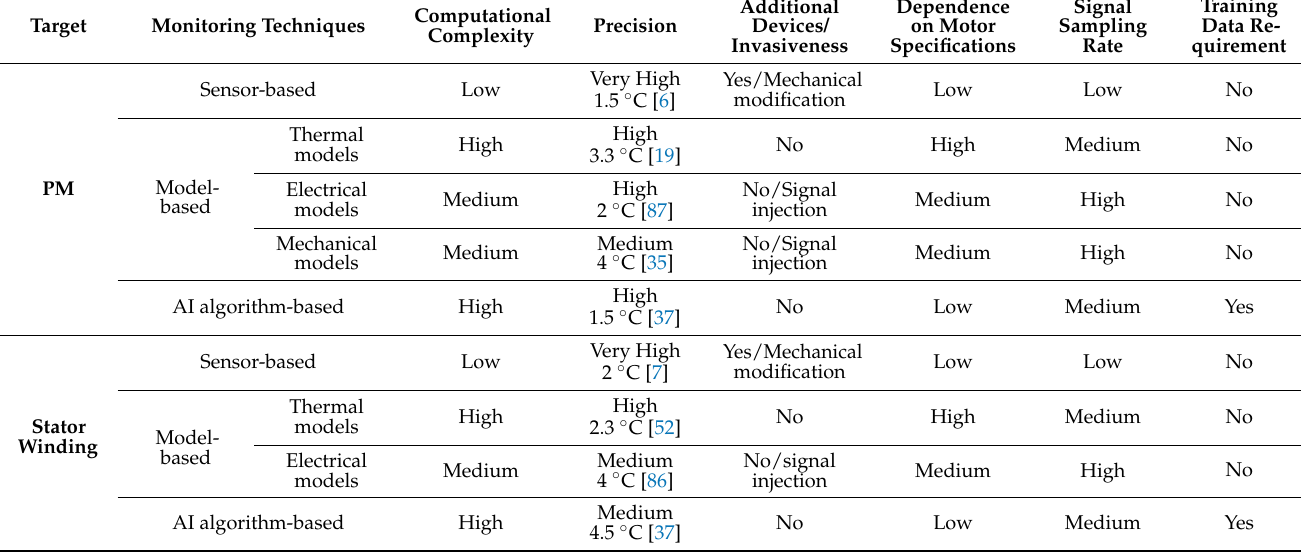
Table 2. Technical comparison of temperature monitoring